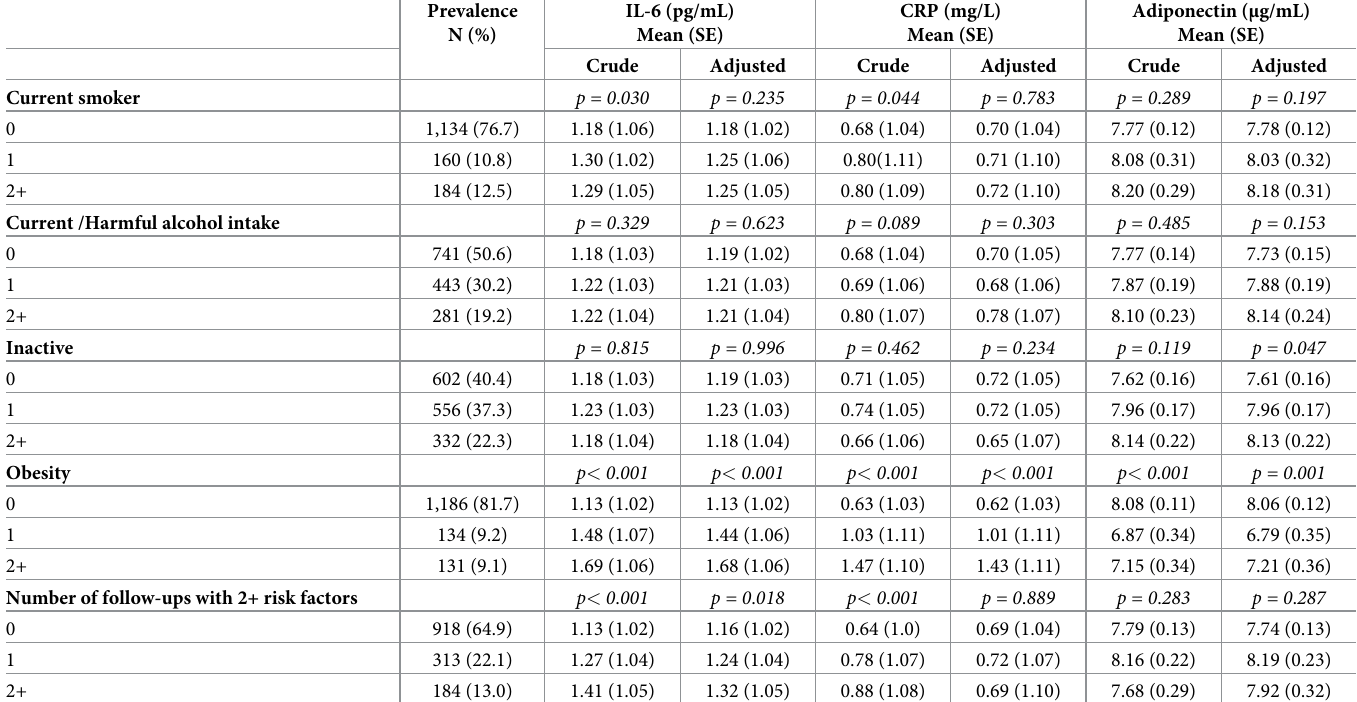
Table 2. Crude and adjusted linear regressions between number of follow-ups presenting each exposure, from 15 to 22 years, and levels of IL-6, CRP and adiponec- tin at 22 years old, males (n = 1,660). The 1993 Pelotas Birth Cohort. Prevalence N